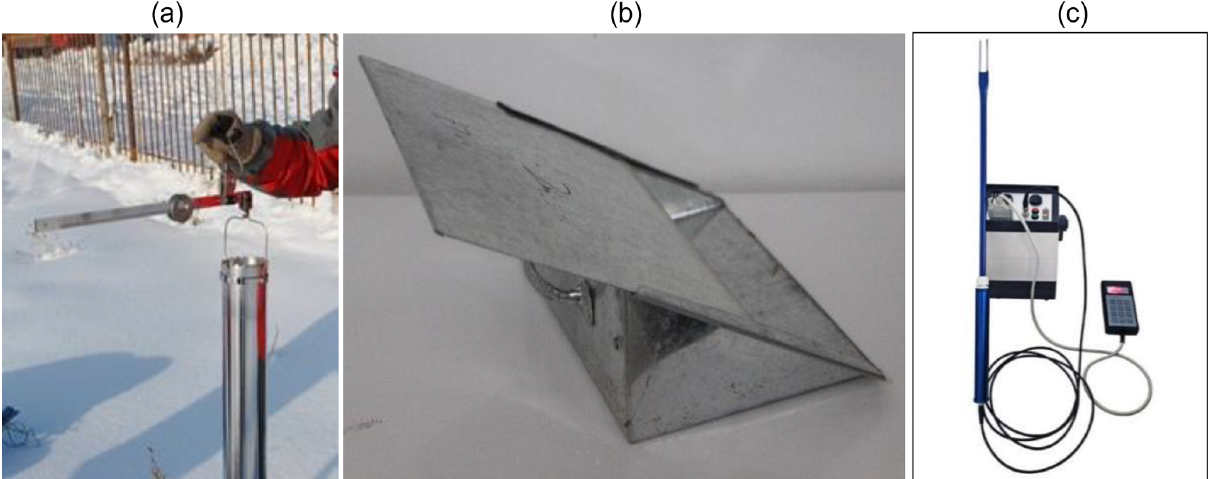
Figure 4. Three instruments for snow density: (a) snow tube, (b) snow shovel, and (c) snow